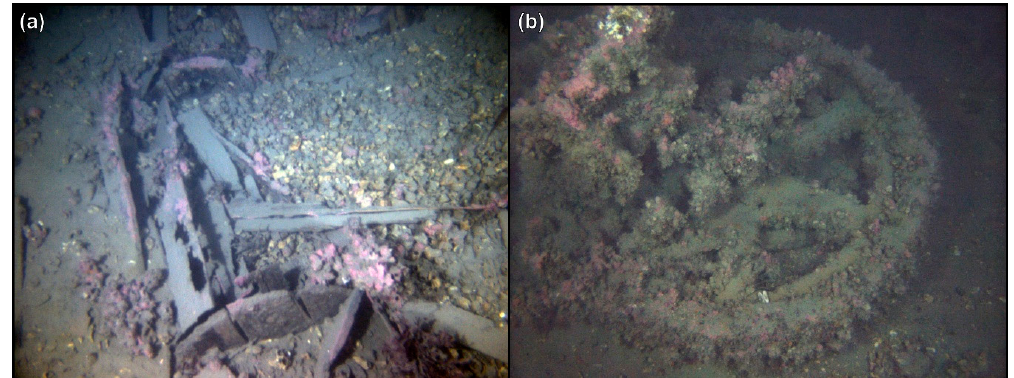
Figure 6. Camera stills from the 2016 remotely operated vehicle (ROV) survey. Panel ( a ) shows the remains of two barrels with lids, and panel ( b ) shows a part of a mechanical metal construction (wheel) completely covered with barnacles.